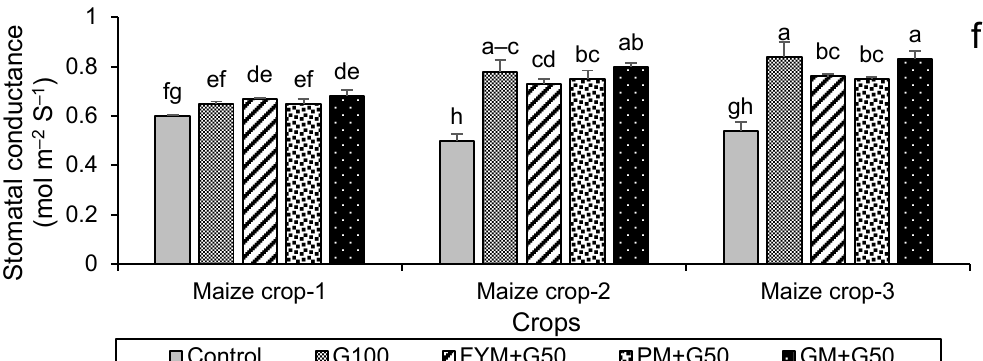
Figure 7. Impacts of different treatments on ( a ) chlorophyl contents, ( b ) photosynthetic rate, ( c ) stomatal conductance of wheat, ( d ) chlorophyl contents, ( e ) photosynthetic rate, and ( f ) stomatal conductance of maize. Error bars represent the standard error ( n = 3). Different letters indicate statistical difference (LSD, p < 0.05).